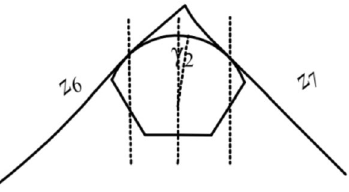
Figure 4. Schematic diagram of the parameters on the right tower saddle.